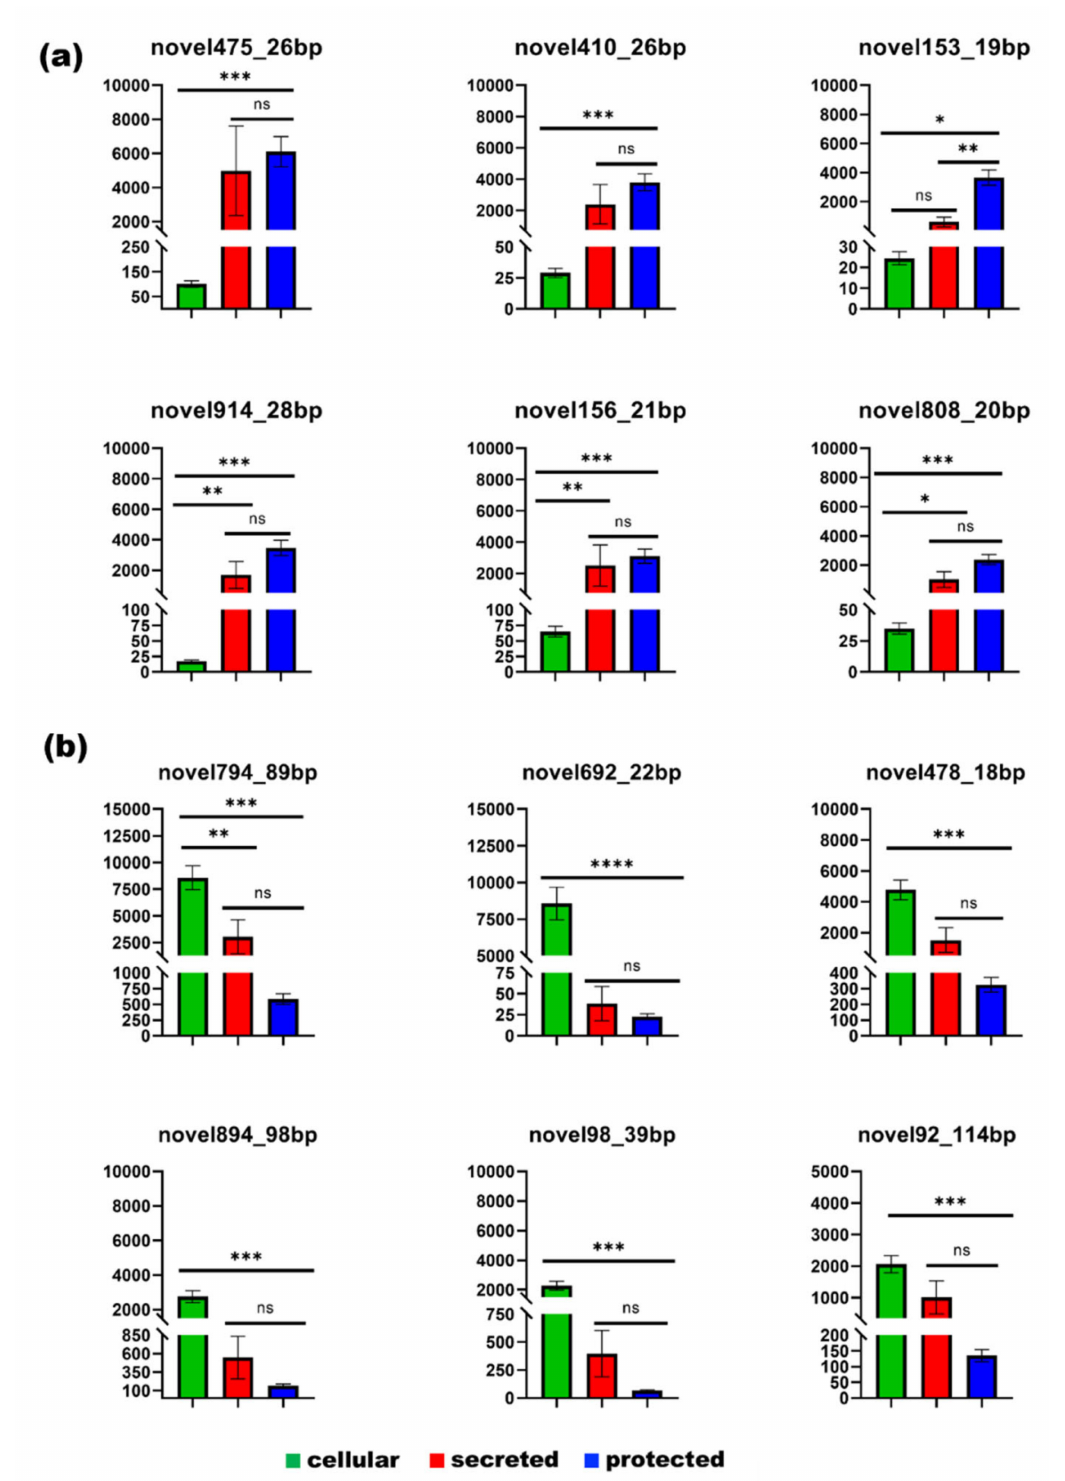
Figure 12. Most represented unannotated RNA: ( a ) the most abundant unannotated RNA in the EV lumen, and ( b ) the most abundant unannotated RNA in the cells (the chromosomal coordinates are in Table